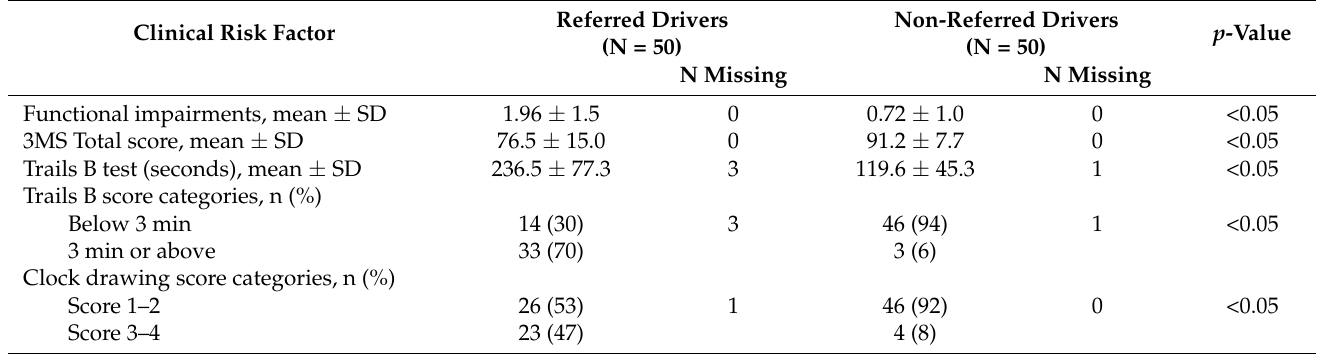
Table 2. Description of clinical risk factors for driving by referral status.